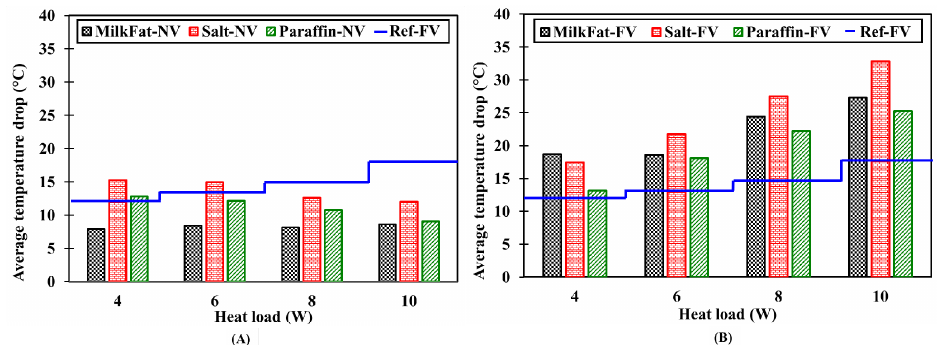
Figure 8. Average temperature difference (ATD) at the HS surface for the operational modes compared to the reference for different PCMs (salt hydrate, paraffin and milk fat subjected to: ( A ) NV; and ( B ) FV at heat power input of (4 W, 6 W, 8 W and 10